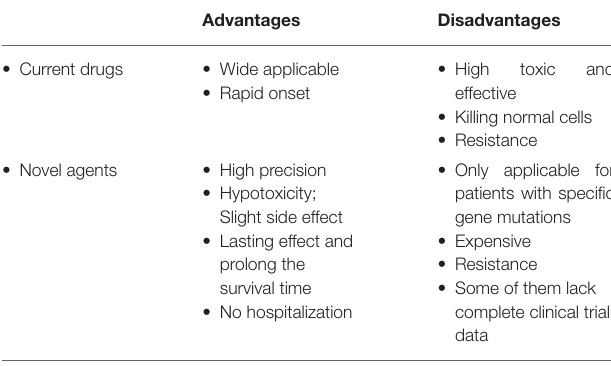
TABLE 3 | Main advantages and disadvantages of current drugs and novel